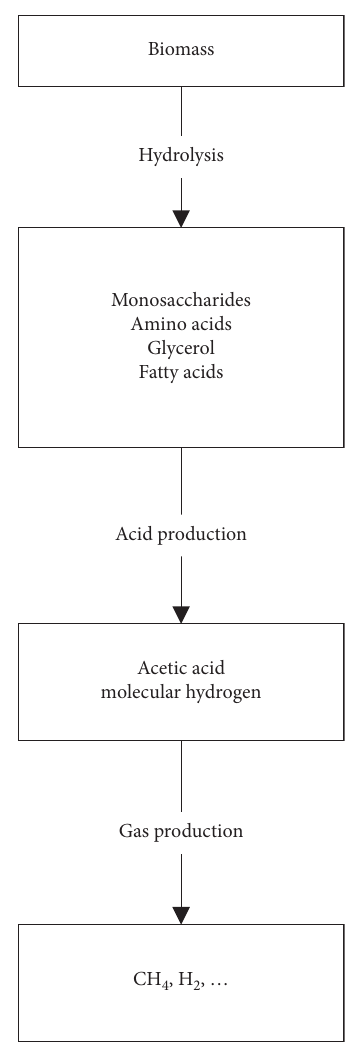
Figure 5: Schematic process of the biogas fermentation